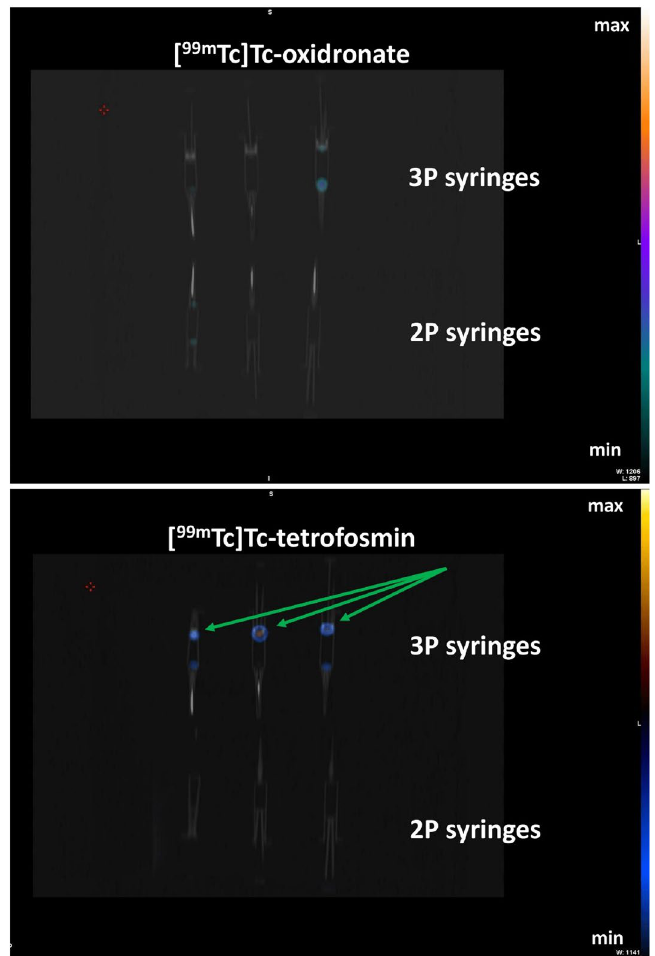
Figure 2. SPECT/CT imaging of [ 99m Tc]Tc-oxidronate and [ 99m Tc]Tc-Tetrofosmin on 2-part and 3-part syringes. Black and white refer to the CT acquisition. Colors refer to radioactive SPECT signal. The green arrows point to the major sites of sorption (plunger